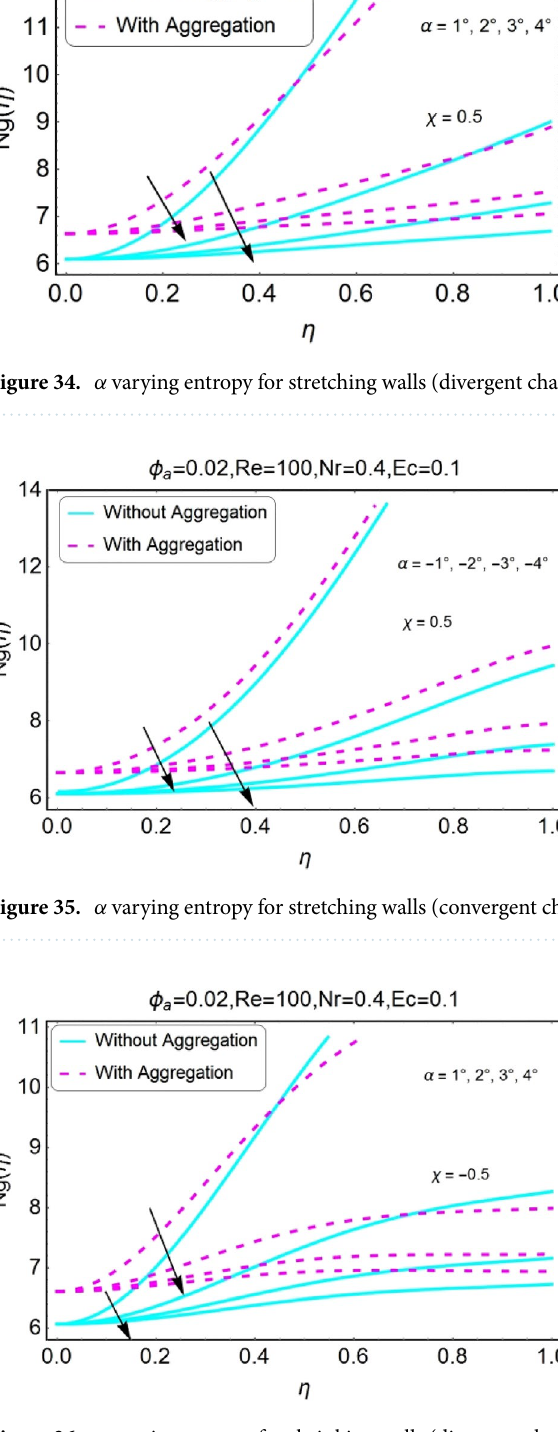
Figure 36. α varying entropy for shrinking walls (divergent